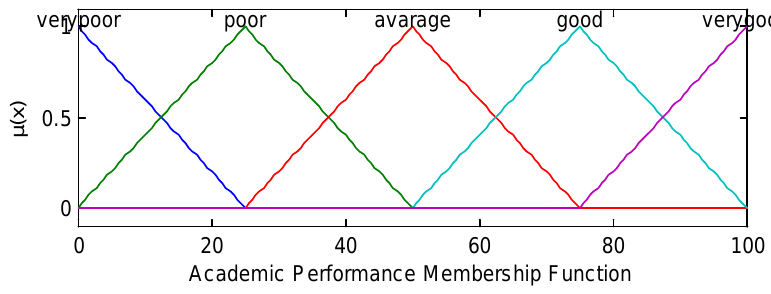
Figure 9 . Academic performance membership function.